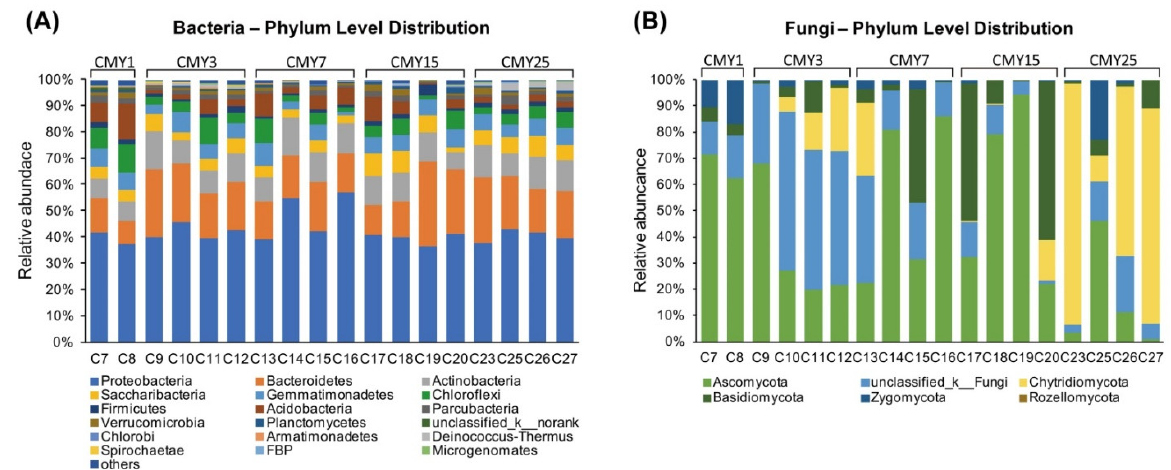
Figure 3. Relative abundance of bacteria ( A ) and fungi ( B ) at the phylum levels in cucumber rhizosphere soil under long-term monoculture systems in greenhouses.